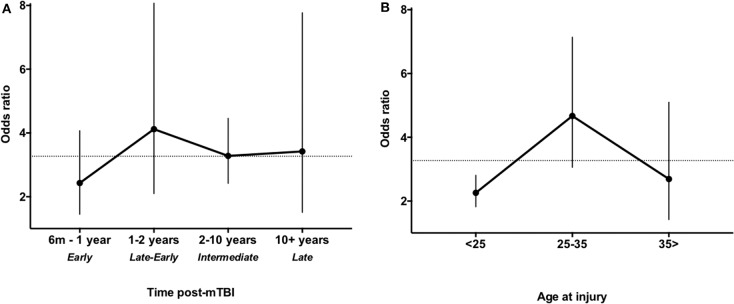
Odds ratio (OR) of depression over time post mild traumatic brain injury (mTBI) (A) and age at injury (B). (A) Data were stratified into early phase (6 months−1 year post-mTBI), late-early phase (1–2 years post-mTBI), intermediate phase (2–10 years post-mTBI), and late phase (more than 10 years post-mTBI). (B) Data were stratified by mean age at injury under 25 years, 25–35 years, or over 35 years. Dashed lines indicate the overall OR.